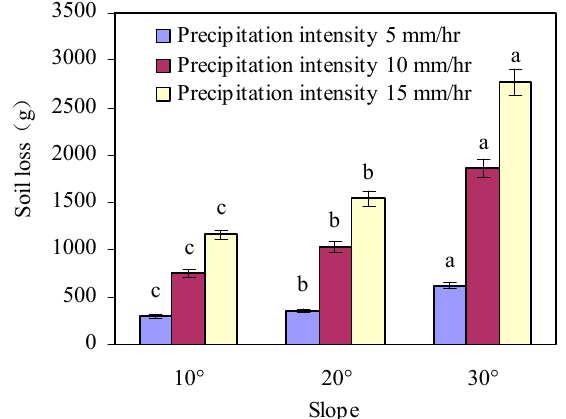
Figure 9. The total soil loss in relation to slope gradient at three rainfall intensities over the entire rain event (e.g., 60 min).